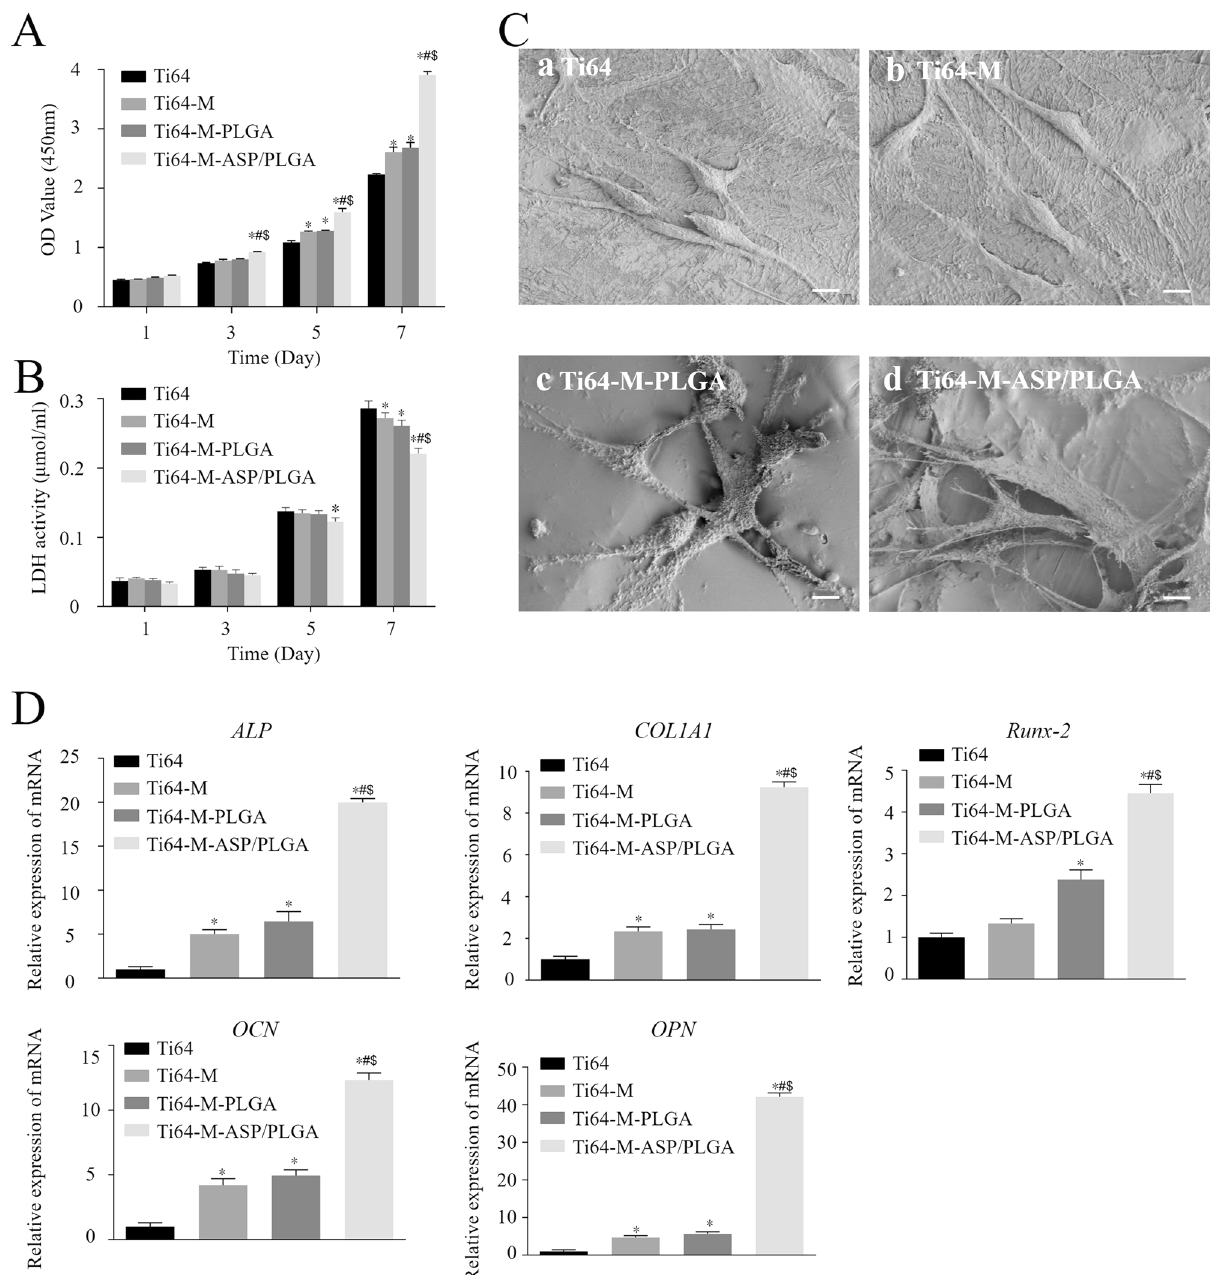
Fig. 5 Effects of different samples on cell proliferation, cytotoxicity, morphology and osteogenesis-relate genes expression of MC3T3-E1 cells. A CCK-8 and B LDH activity results of MC3T3-E1 cells for 1, 3, 5 and 7 days. C SEM images of MC3T3-E1 cells after 24 h of culture. D Osteogenesis-related gene levels of MC3T3-E1 cells after displayed spindle shape. While cells on the Ti64-M-PLGA surface revealed better spread-out morphology than the Ti64 and Ti64-M surfaces, with more fi lopodia and lamel- lipodia stretching out and adhered to the surfaces. Particu- larly, cells on the Ti64-M-ASP/PLGA substrate displayed the best well-spread morphology, with numerous well-